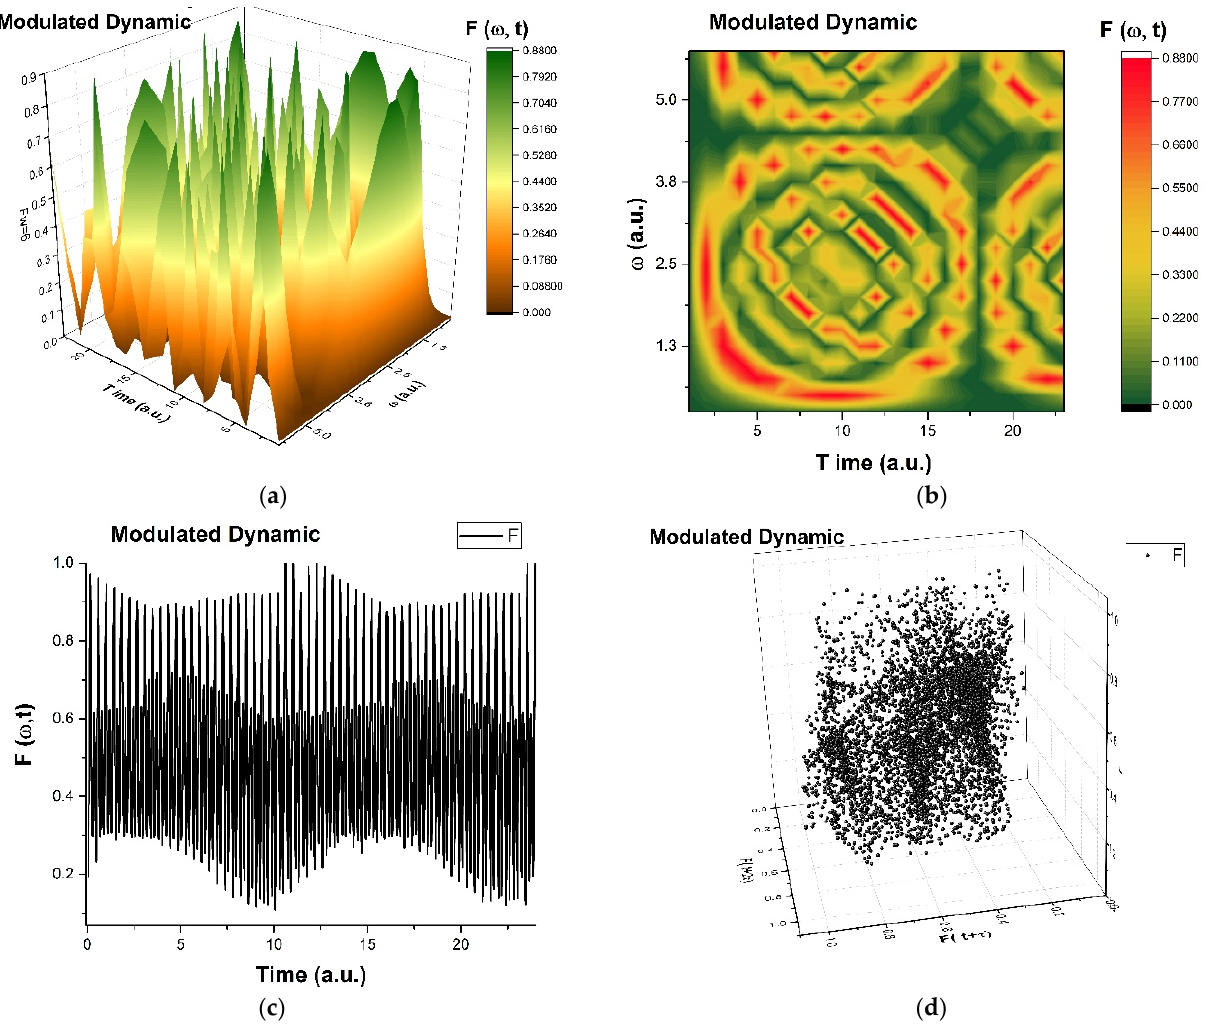
Figure 8. ( a – d ): The ”modulated dynamic modes” in mastication of the structural units of dental composite materials dynamics are presented: ( a )—3D diagram, ( b )—contour diagram, ( c )—time series and ( d )—reconstituted attractor for scale resolutions given by Ω max .